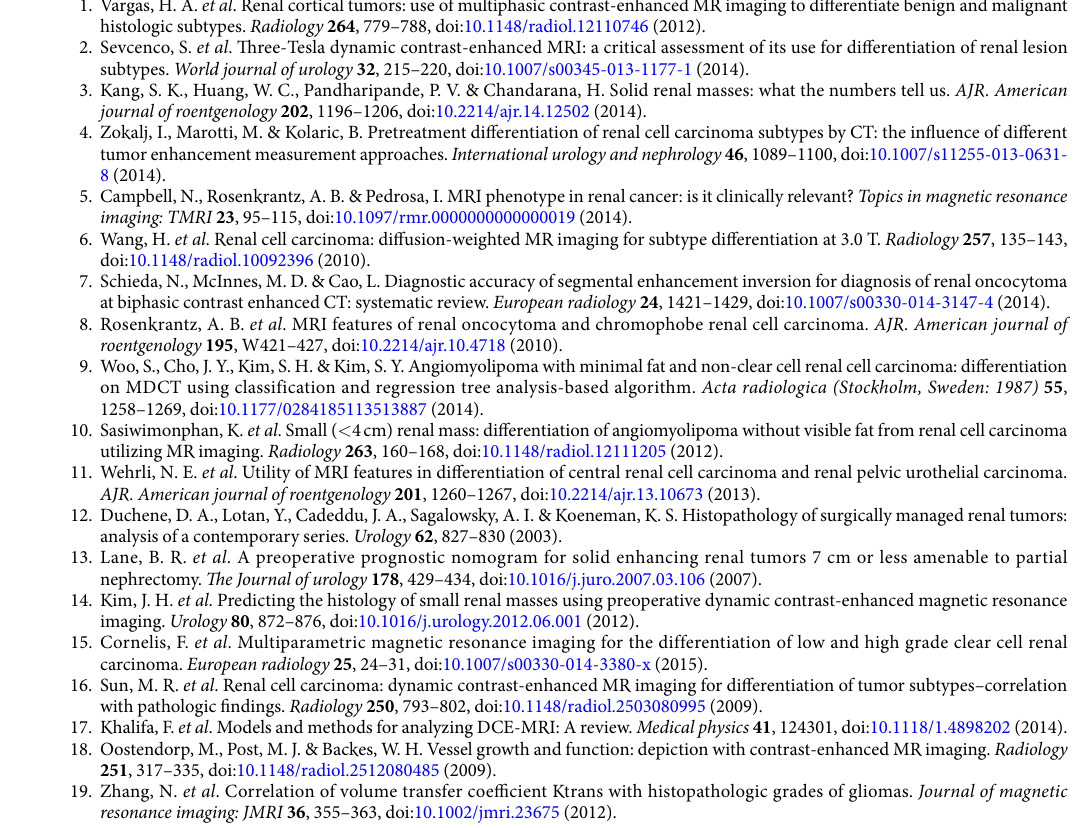
analysis of pharmacokinetics should be attempted. Third, we were unable to enroll patients with renal oncocy- toma, as this is a relatively rare disease, making it difficult to obtain an appreciable sample size. Previous work indicates that oncocytoma has a similar K trans and V e as ccRCC 31 , but our sample size was small (n = 3). Thus, additional research is required to validate our findings. Finally, a few patients in our center chose CT instead of MRI for imaging, and of those who agreed to undergo MRI examination, many could not endure the lengthy DCE-MRI process. In conclusion, DCE-MRI kinetic measurements are promising for the differential diagnosis of renal tumors, especially for RCC subtype characterization, and for distinguishing between fpAML and non-ccRCC.